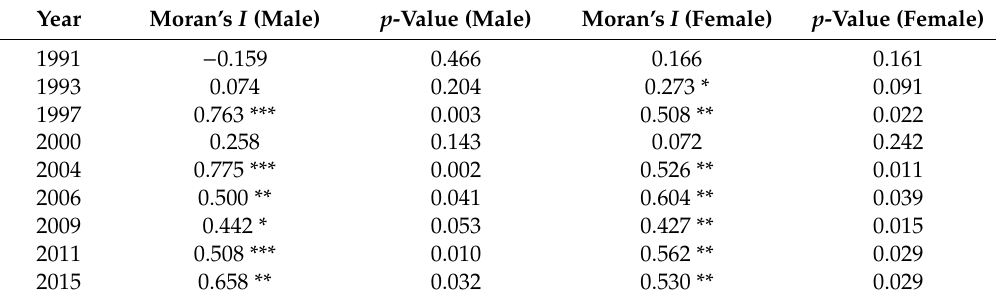
Figure 4. Area-specific hypertension prevalence (female). Furthermore, the global Moran’s I and corresponding p -value were calculated for all study periods in order to assess the spatial correlation of hypertension prevalence (Table 2). It showed that though fluctuated during the study periods, Moran’s I was significantly positive, with an exception for males in 1991. This indicated that the hypertension risk was significantly spatially clustered, thus, it is reasonable to construct a spatio-temporal model.